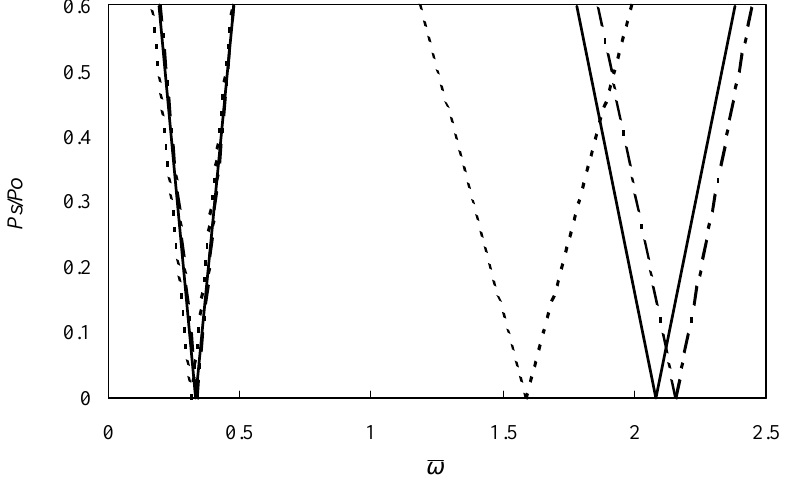
Fig. 4. First two instability regions for a rotating beam with a single crack at mid-span, Ω = 1 and L = 1 . 0 m. ‘-.-.-’ a/h = 0 . 25 , ‘– ’ a/h = 0 . 50 , ‘- - -’ a/h = 0 . 75